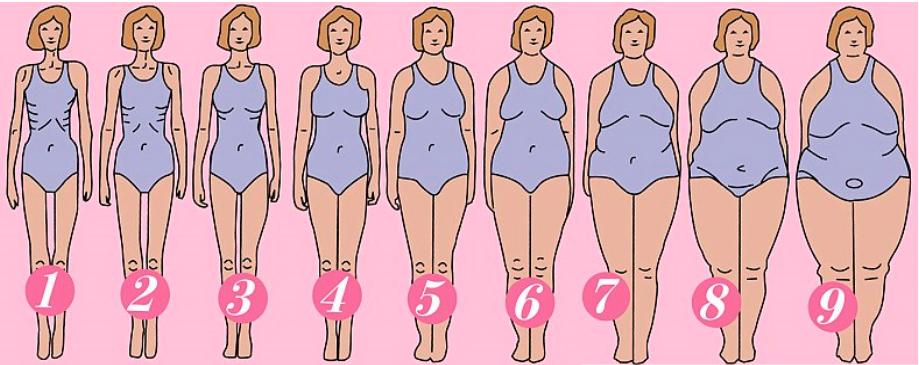
Figure A1. Current Body Size.